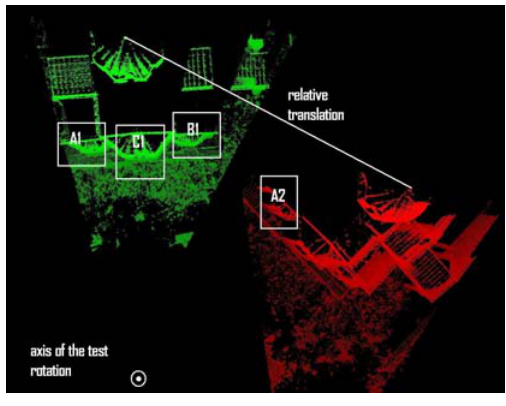
Figure 15. Top and side views of the Agia Sanmarina church data for the convergence region test in the case of the large translation, i.e. [dx, dy, dz] = [0.5 m, 0.5 m, 1.0 m]. Green is the east of the church. The red point clouds in (a) and (b) are the northeast and the southeast of the church,